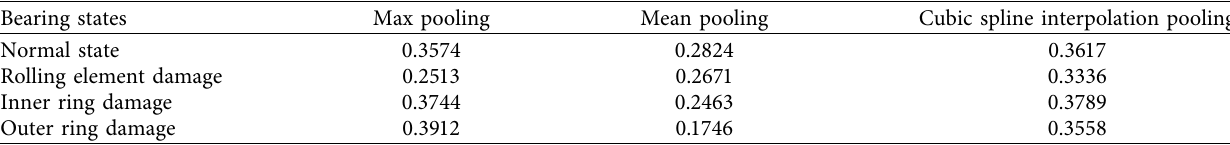
Table 2: Correlation coefficients between the proposed method and the input